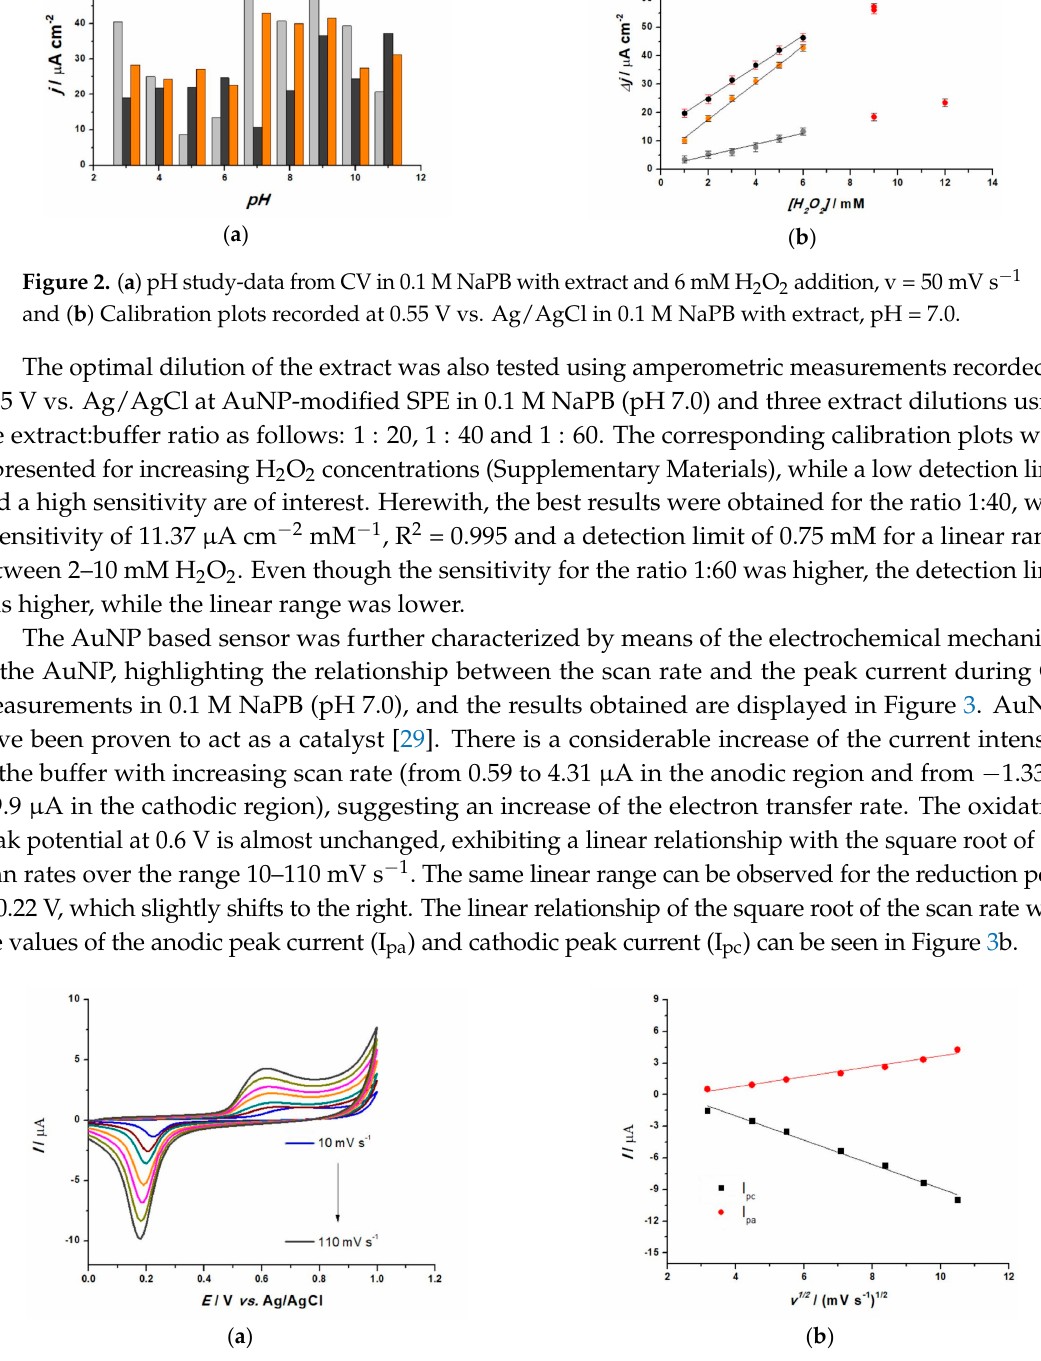
Figure 3. ( a ) Cyclic voltammograms in 0.1 M NaPB, pH = 7.0 at AuNP-modified sensor for different scan rates: 10, 20, 30, 50, 70, 90 and 110 mV s − 1 ; ( b ) Plots of both peak currents I pa and I pc vs. the square root of the scan rate.